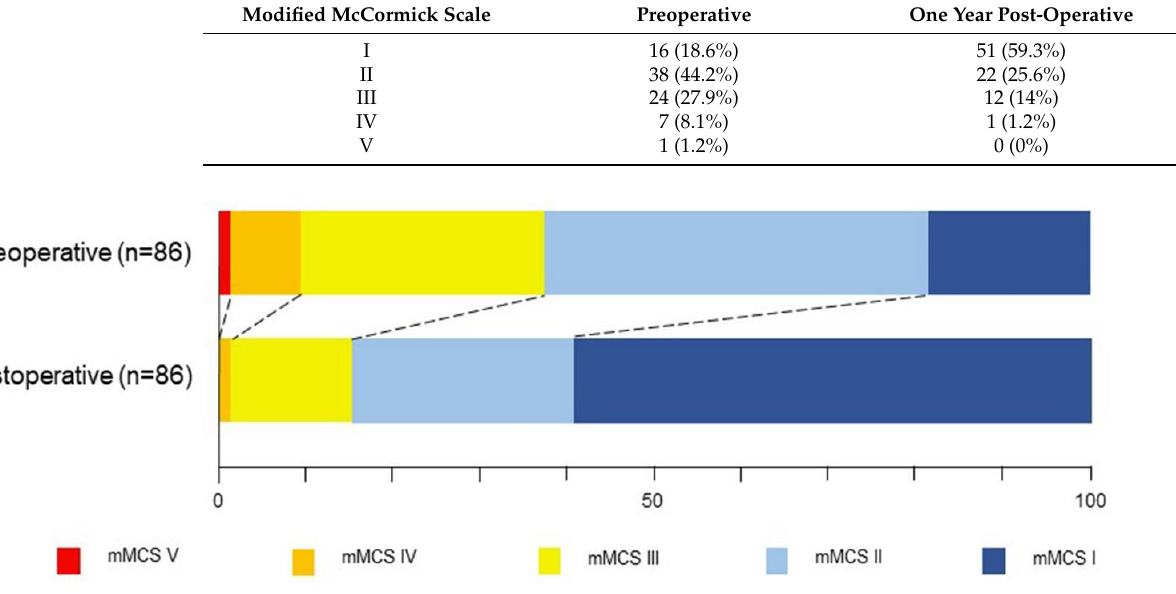
Figure 2. Modified McCormick Scale pre and post-operative at 1-year follow-up. Most of the patients (57/86; 66.3%) showed improvement of at least one grade. The median preoperative Modified McCormick Scale score was II whereas the median post-operative score was I ( p < 0.001). mMCS: Modified McCormick Scale. Table 2. Pre and post-operative modified McCormick Scale.